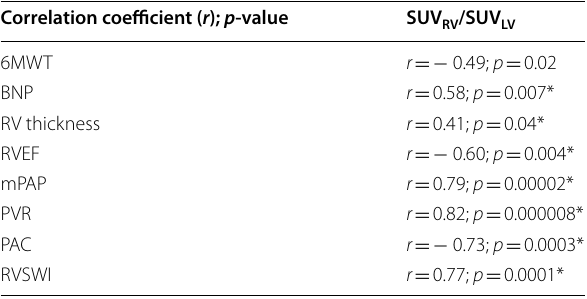
* p -value significant (< 0.05) after Benjamini–Hochberg correction BNP B-type natriuretic peptide, FU Follow-up, LV Left ventricle, MRI Magnetic resonance imaging, mPAP Mean pulmonary arterial hypertension, 6MWT 6 min walk test distance, PAC Pulmonary arterial compliance, PET Positron emission tomography, PVR Pulmonary vascular resistance, RHC Right heart catheterization, RV Right ventricle, RVEF Right ventricle ejection fraction, RVSWI Right ventricle stroke work index, SUV Standardized uptake value